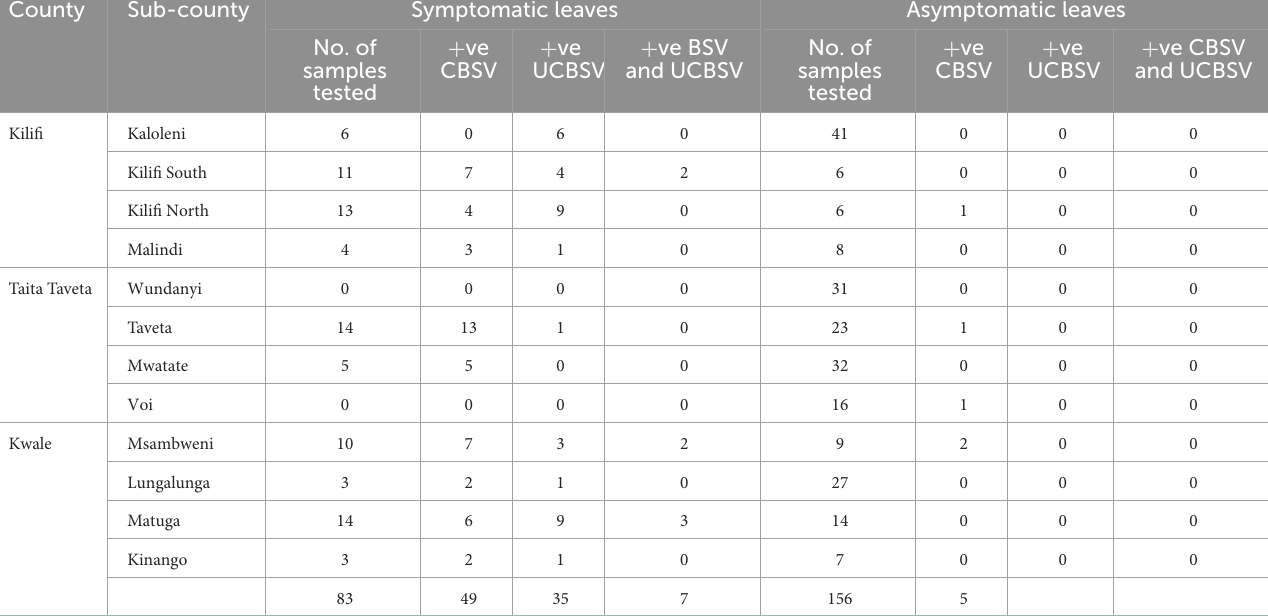
TABLE 7 Cassava leaf samples analyzed for the presence of cassava brown streak viruses by RT-PCR. County